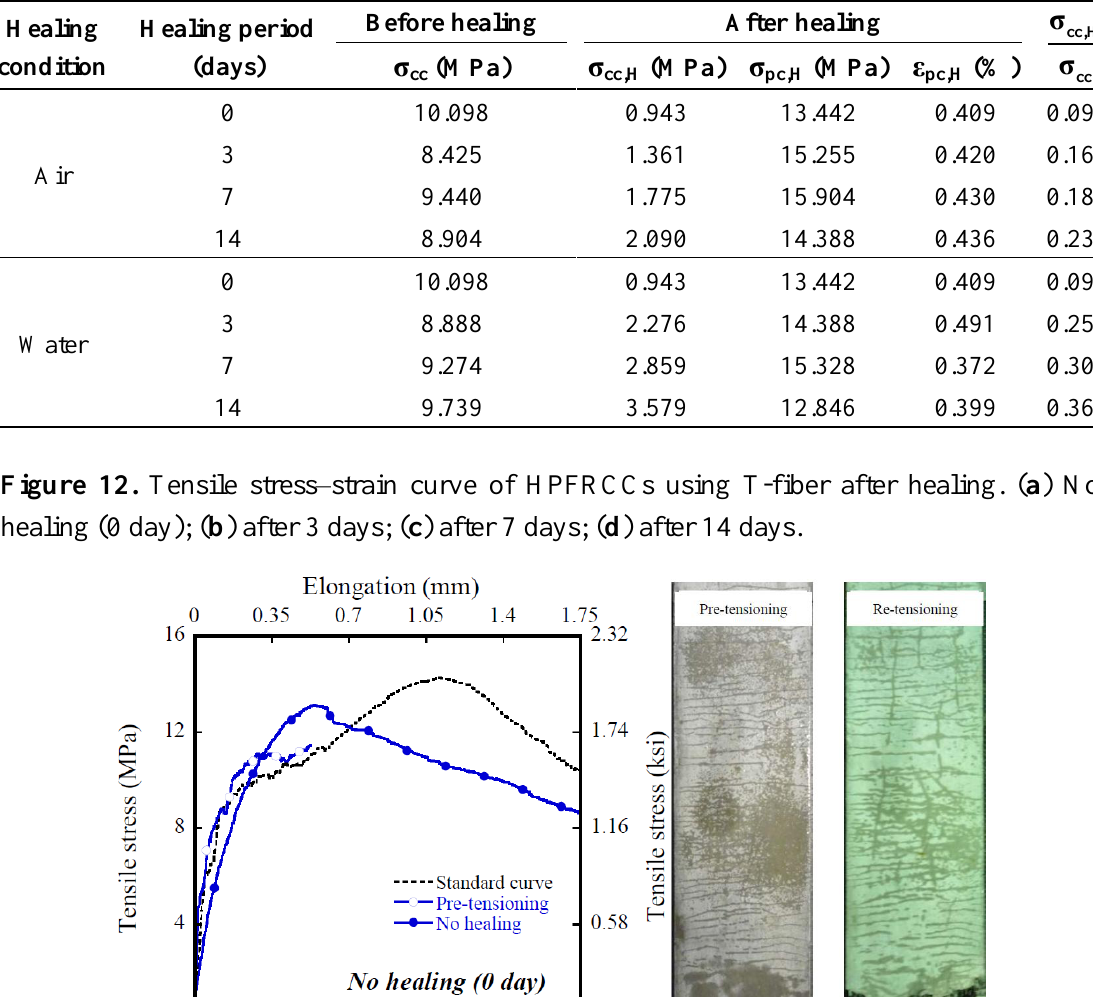
Table 4. Mechanical recovery of HPSFRCs according to different healing conditions.